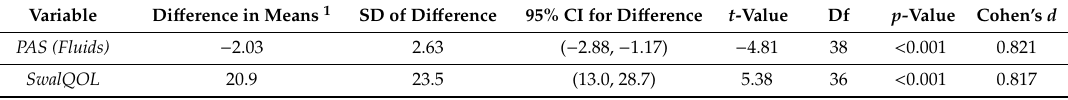
Table 9. Parameters from paired-samples testing: all patients not su ff ering from medical deterioration.